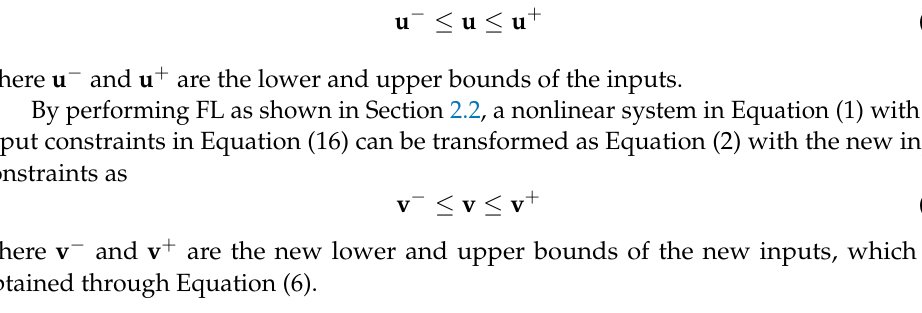
Table 1. Comparisons of the four transformations. SDC Transformation TSF Model JL FL Parameterization Schemes Redefine states and N Y N N inputs Linear or linear-like Linear Linear Linear-like Linear-like Approximated or Approximated Same Same Approximated same representations Condition satisfied N Y Y N Design flexibility N Y Y Y Formulation N Y N Y complexity Computation cost Low Low High